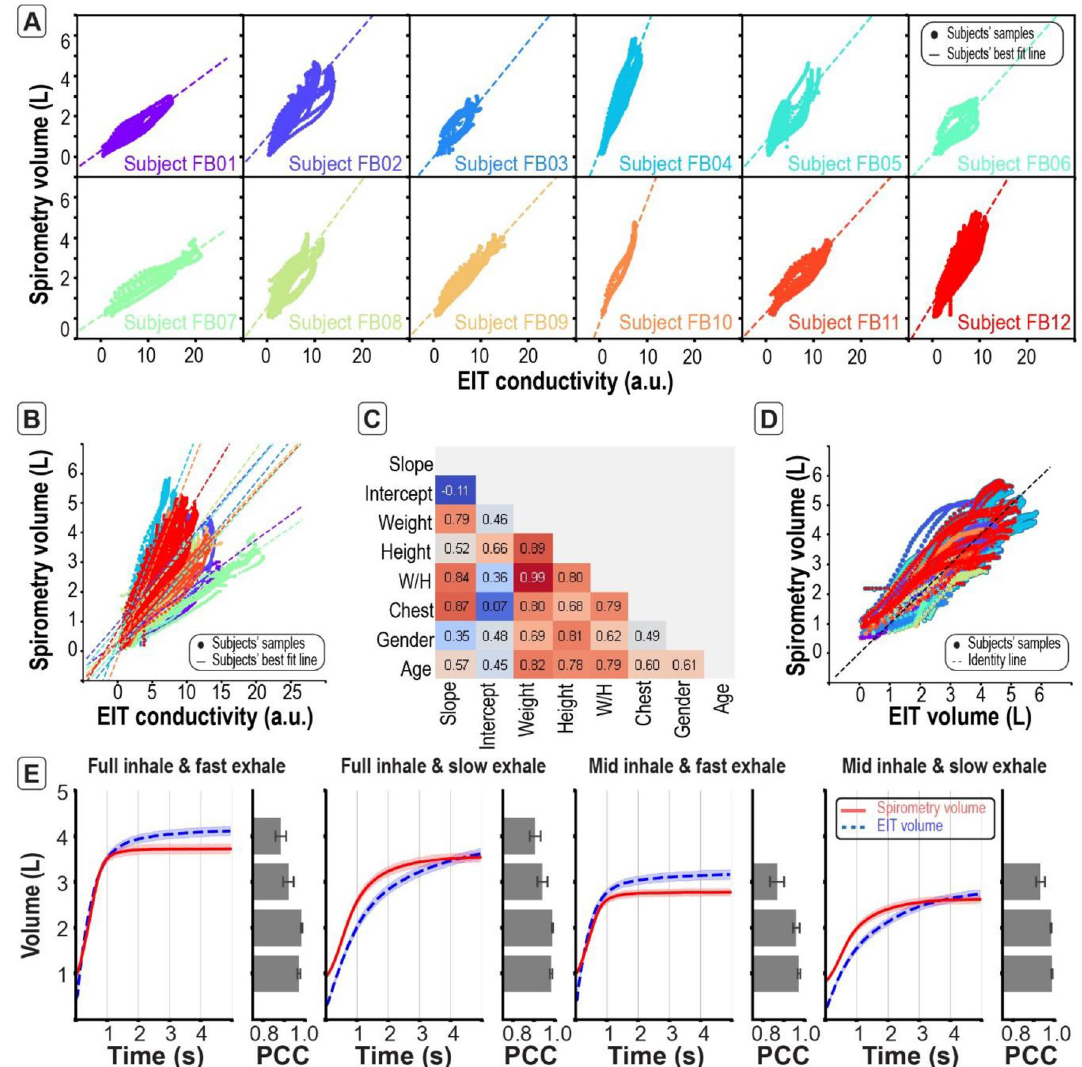
Figure 2. With anthropometric correction, the developed EIT system can be used as a standalone device to predict lung volume change over time. ( A ) Global EIT conductivity-time curves are significantly correlated with volume-time curves for individual subjects. These indicate that the relation between conductivity and volume are quasi-linear and subject-dependent. ( B ) The relation between conductivity-time curves and volume-time curves is subject dependent. ( C ) The correlation matrix between the slope, intercept and subjects’ anthropometrics shows that the slope is highly correlated with the weight-height ratio (W/H) and the chest circumference (Chest). ( D ) The predicted volume-time curves using EIT and subjects’ anthropometrics are highly correlated with the measured volume-time curves. The train and test samples are shown in Supplementary Figure S5 ( E ) The mean (± standard error) of the predicted volume-time curves is in agreement with the mean (± standard error) of the measured volume-time curves for all breathing efforts as shown by the bar plots of the Pearson’s correlation coefficient (PCC; ± standard error) computed on the volume segments 0-1L, 1-2L, 2-3L, and height and/or chest circumference has larger slope and hence for those subjects a smaller change in conductiv- ity is related to a larger change in volume. Since both weight/height and chest circumference are proportional to the volume of the conductive medium, the larger these quantities, the larger the resistance and the slower the change in conductivity. Hence, the weight/height and the chest circumference are used in addition to the conductivity to train a regression model for predicting the volume. The sought model should have a W/H and chest-dependent slope. This is equivalent to a linear regression model with dependent variables which include product terms of anthropometric parameters and conductivity. Since the W/H ratio is strongly correlated with the weight (PCC > 0.98; p < 0.001), weight was not included to avoid multi-collinearity. To ensure that the regression model is capable of generalizing to unseen data from subjects with different anthropometrics and to fairly evaluate the model performance, the data is split into training- and testing-samples. The test-samples are obtained by randomly excluding all data from two subjects and another 10% of the data from